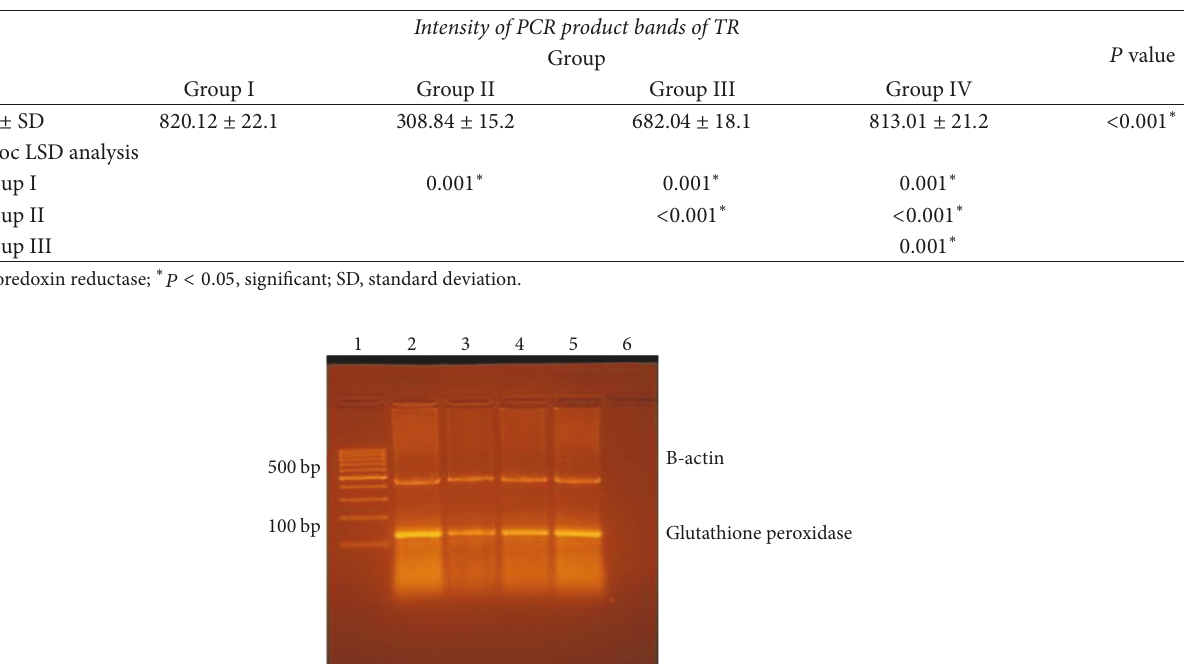
Table 7: One-way ANOVA statistical analysis of the intensity of the PCR product bands of TR among different experimental groups (𝑛 = 10) .